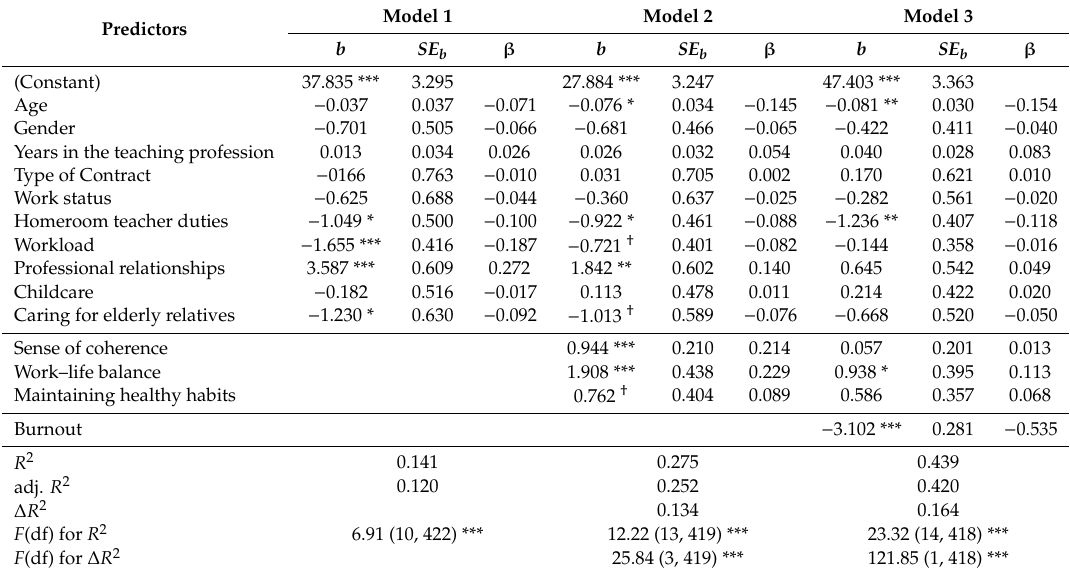
Table 3. Linear regression for work ability (WAI) as